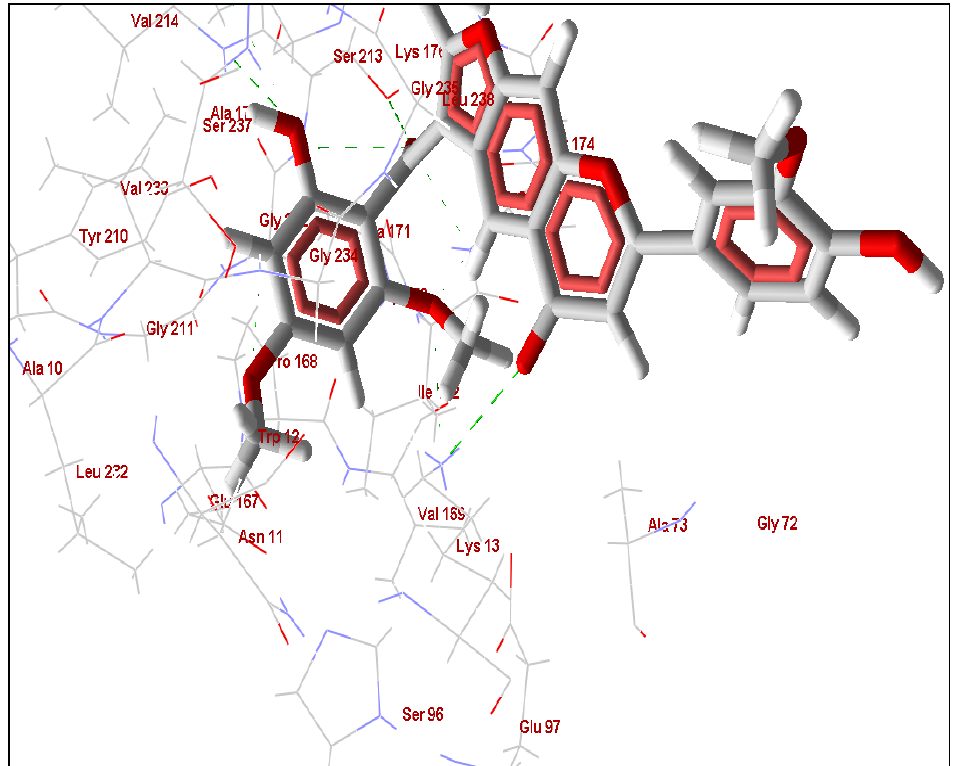
Supplementary Figure 4. Predicted orientation of cissampeloflavone around the glycine and serine residues at the HPO 42- binding